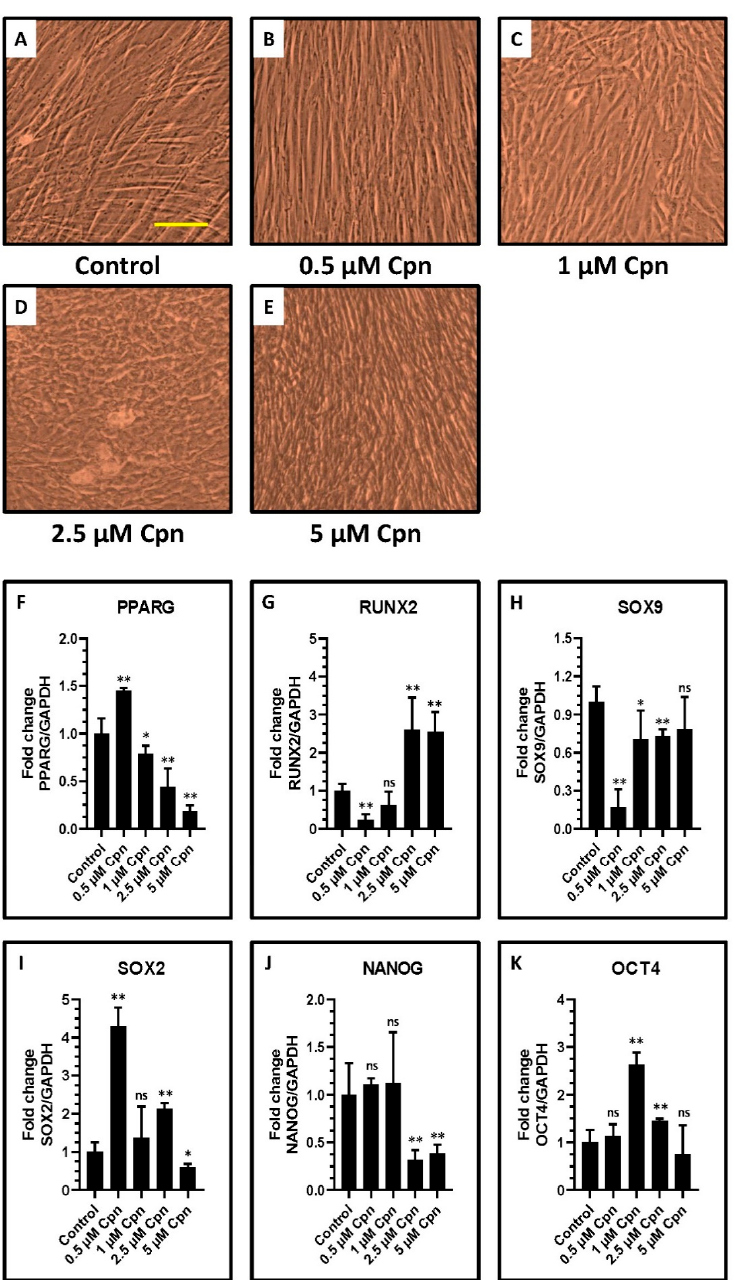
Figure 6. Morphology and analysis of gene expression in DPSCs treated with various concentrations of cordycepin (0.5 µM, 1 µM, 2.5 µM, and 5 µM) for a prolonged time of 7 days. ( A – E ) Photomicrograph of DPSCs after 7 days of incubation with various treatments. ( F – H ) Comparative gene expression analysis of PPARG (adipogenesis master regulator gene), RUNX2 (osteogenesis master regulator gene), SOX9 (chondrogenesis master regulator gene). ( I – K ) Comparative gene expression analysis of SOX2, NANOG, and OCT4 (stemness-related transcription factors). ns not significant, * p < 0.05, and ** p < 0.01. Cpn: Cordycepin, ROS: Reactive oxygen species, PPARG: Peroxisome proliferator-activated receptor-gamma, RUNX2: Runt-related transcription factor 2, SOX9: SRY-box transcription factor 9, SOX2: SRY-box transcription factor 2, NANOG: Nanog homeobox, and OCT4: Octamer-binding transcription factor